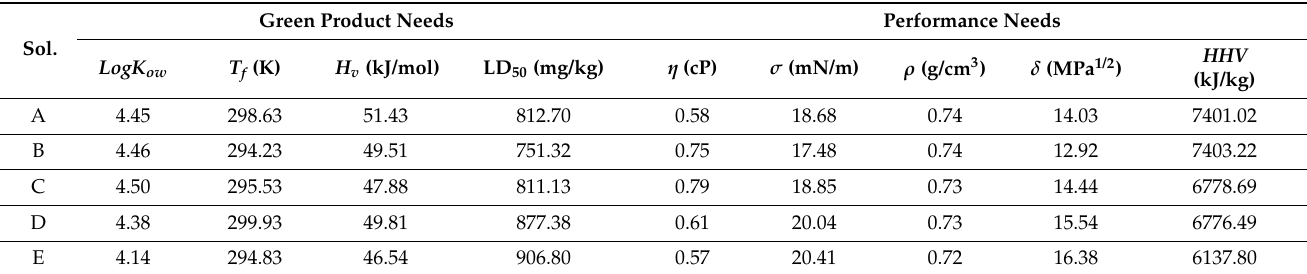
Table 6. Product specifications of designed product.